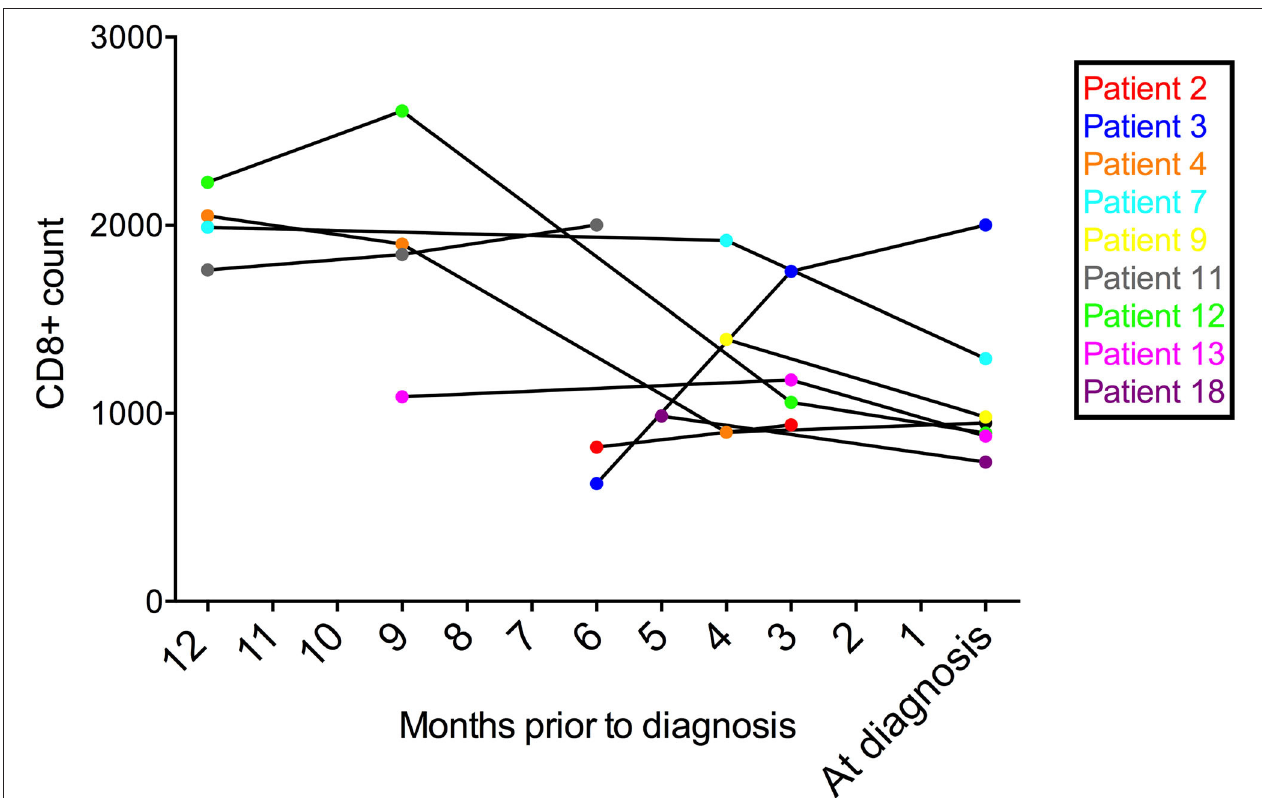
FIGURE 3 | Graph of blood CD8 + T-cell counts from nine patients over the year prior to presenting with HIV-CD8E.